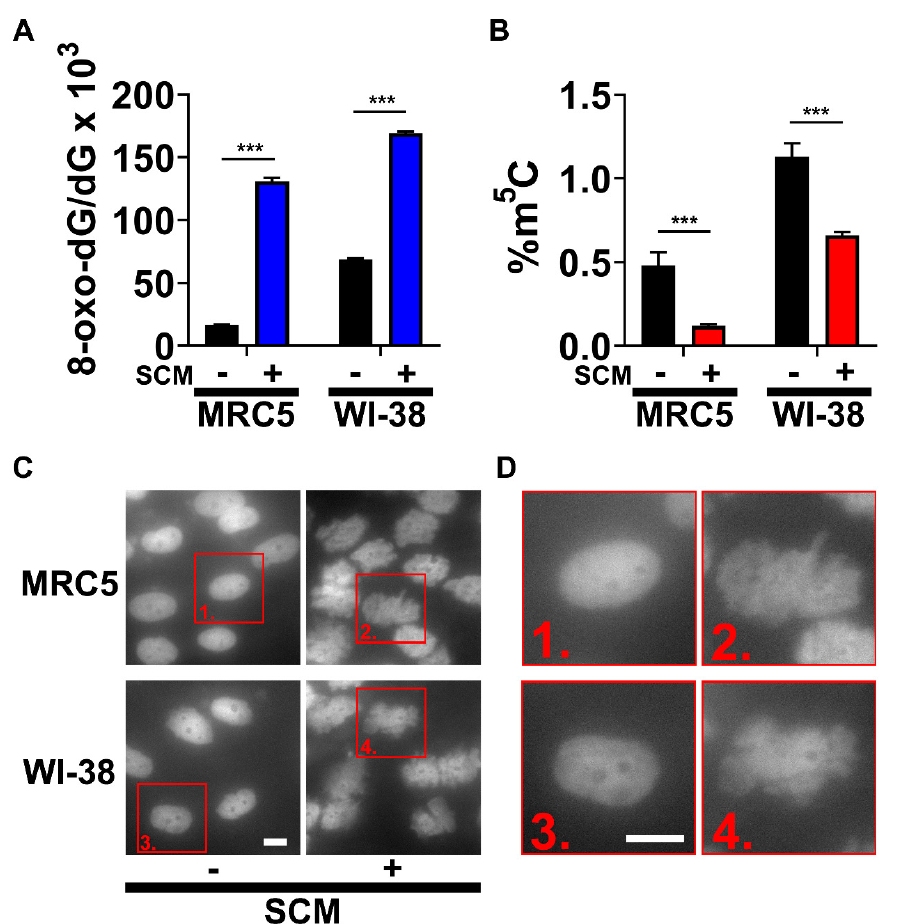
Figure 1. DNA oxidation and nuclear blebbing in WI-38 and MRC5 cells. ( A ) Quantification of 8-oxo- dG in DNA at 24 h using electrochemical detection. ( B ) Quantification of m 5 C in DNA at 24 h using a thin-layer chromatography method. ( A , B ) Student's t-test; bars represent standard deviation and asterisks indicate statistical significance (***, p ≤ 0.001; n = 4). ( C ) Representative fluorescence microscopy images of stained nuclei at 36 h. ( D ) Nuclei labeled 1–4 from C are enlarged (scale bars, 10 µm).